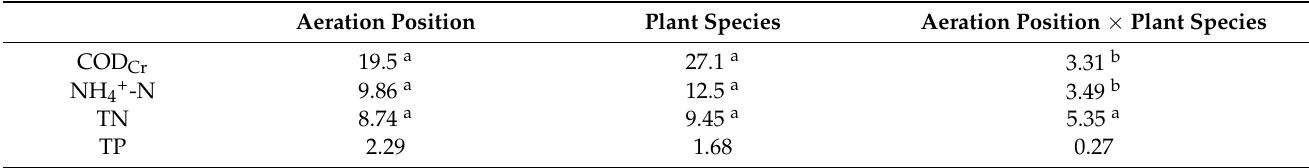
Table 1. F-values and significance of a two-way ANOVA for the effects of aeration position and plant species on HSSF CW treatment